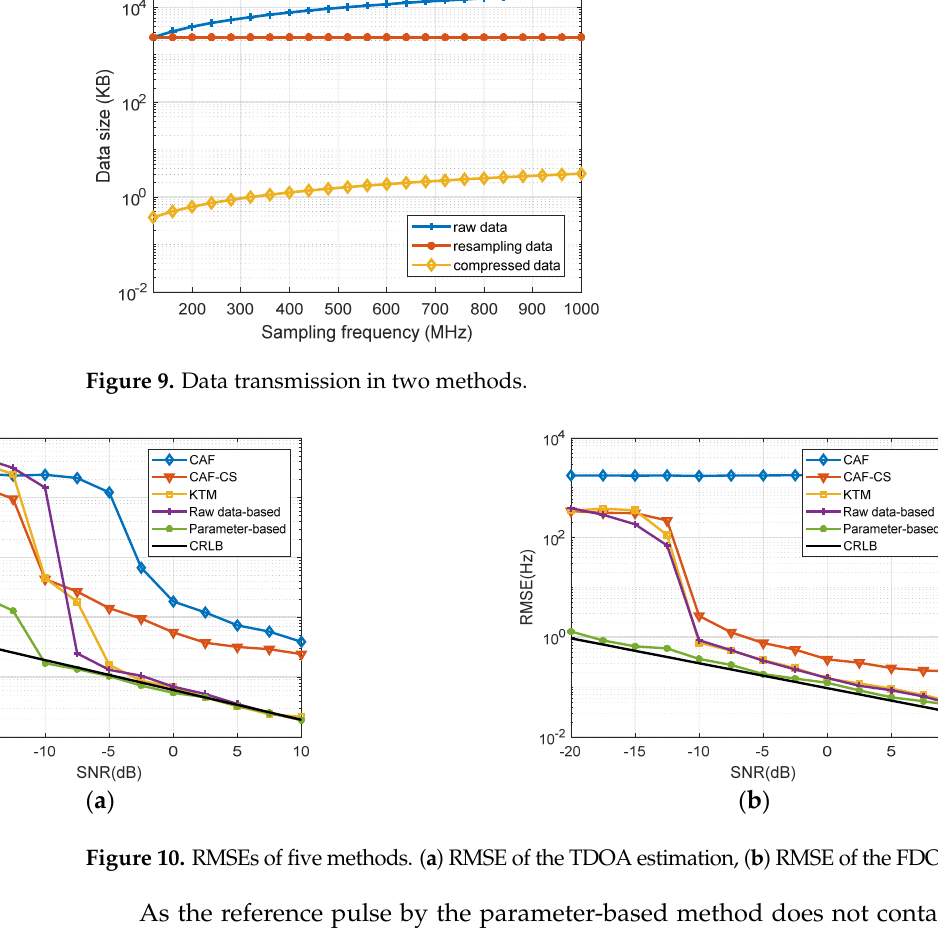
Figure 11. Relationships of input and output SNRs. 5.3. Hardware-in-the-Loop Data We performed a hardware-in-the-loop simulation to examine the proposed method’s feasibility further. The signal parameter-based approach was adopted to complete the data compression since the signal parameters are known. The parameters are tabulated in Table 3.